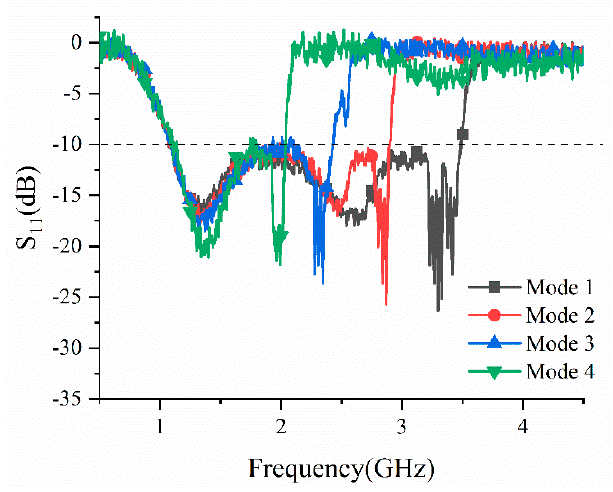
Figure 7. Fabrication of the proposed antenna.